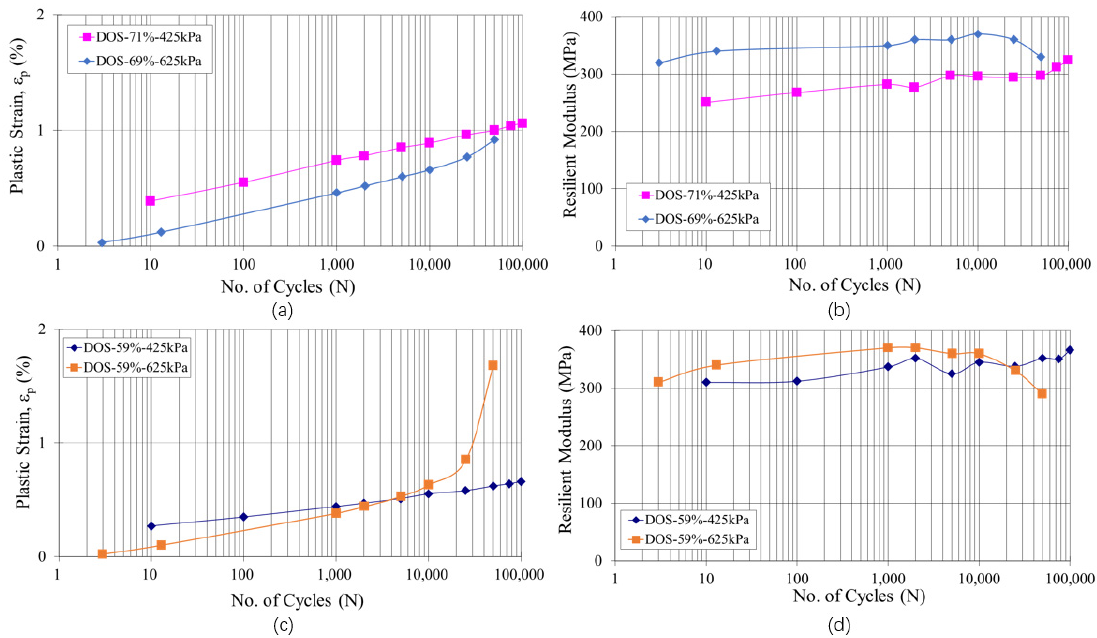
Figure 6. The comparison of resilient modulus and plastic strain versus the number of cycles at similar DOS: ( a ) plastic strain of DOS at around 70%; ( b ) resilient modulus of DOS at around 70%; ( c ) plastic strain at DOS around 59%; and ( d ) resilient modulus at DOS around 59%.